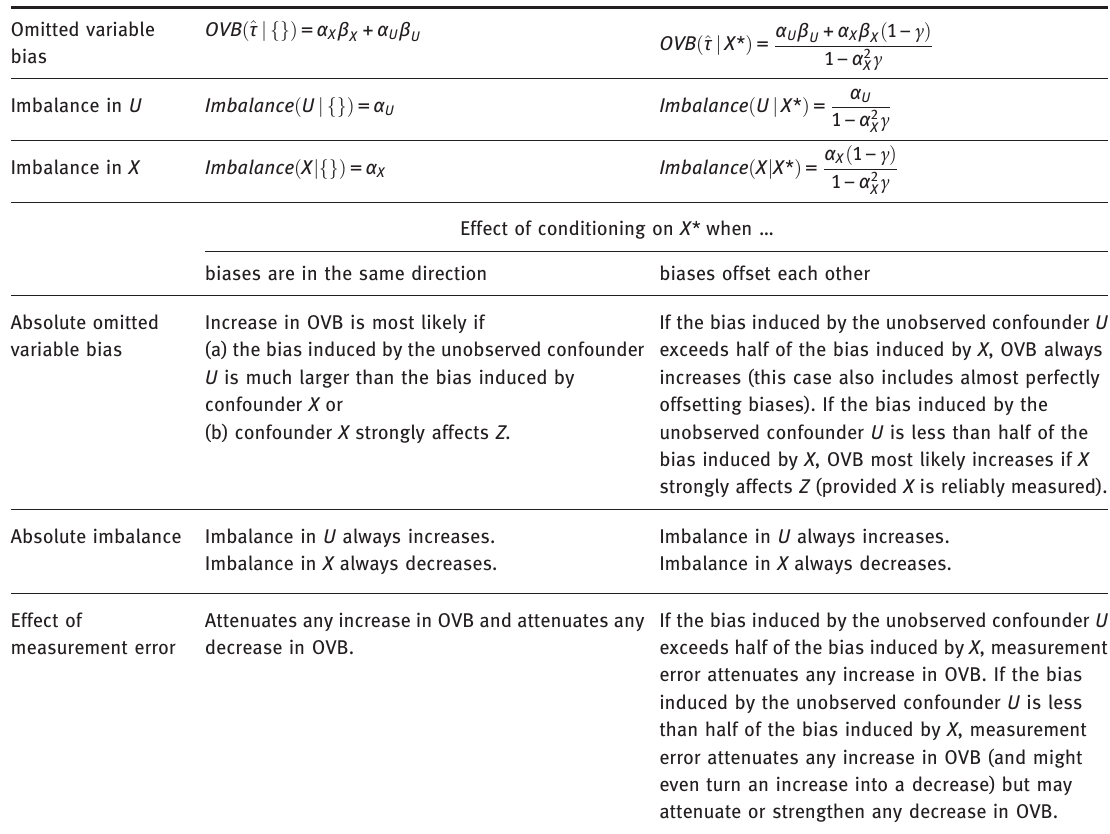
Table 1: Uncorrelated confounders X and U : Omitted variable bias (OVB) and imbalance before and after adjusting for X* . Initial OVB and Imbalance OVB and Imbalance after adjusting for